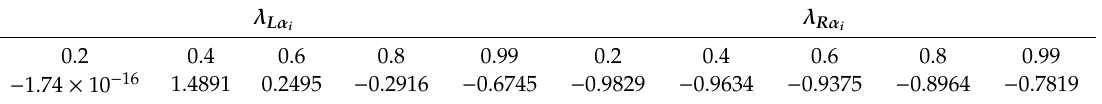
Table 3. Table 3. Left and right lambda values generated by each alpha cut.